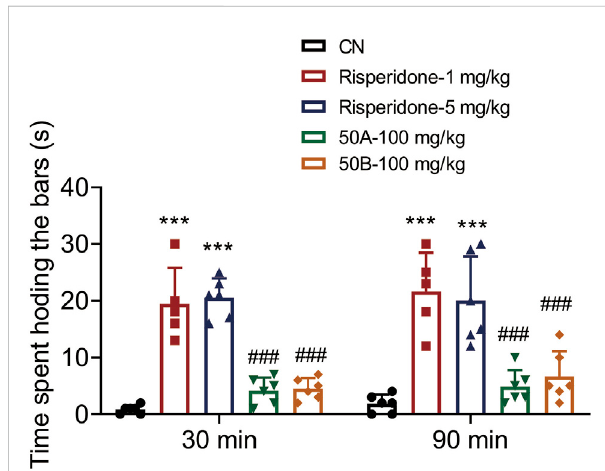
FIGURE 6 50A and 50B did not induce catalepsy in male mouse bar test. Results are expressed as mean ± SD ( n = 5 – 6). *** p < 0.001 versus the control group (CN); ### p < 0.001 versus 1 mg/kg of the risperidone group.